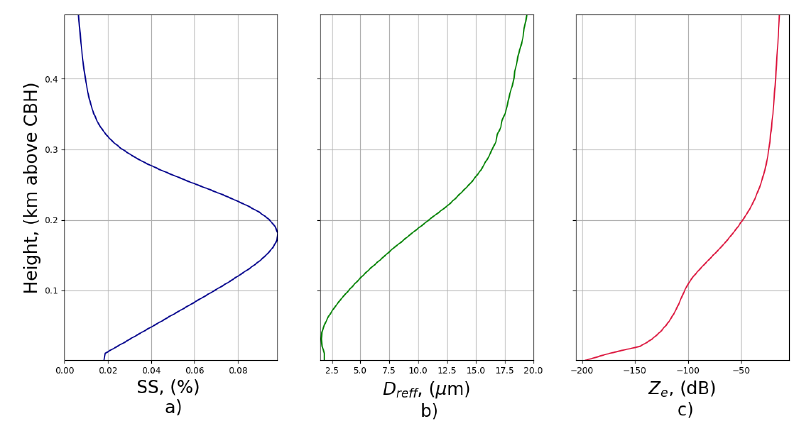
Figure 3. ( a ) Supersaturation (SS), ( b ) droplet effective radius ( D ref f ) and ( c ) backscatter attenuated ( β att ) profiles retrieved from LARSS within the